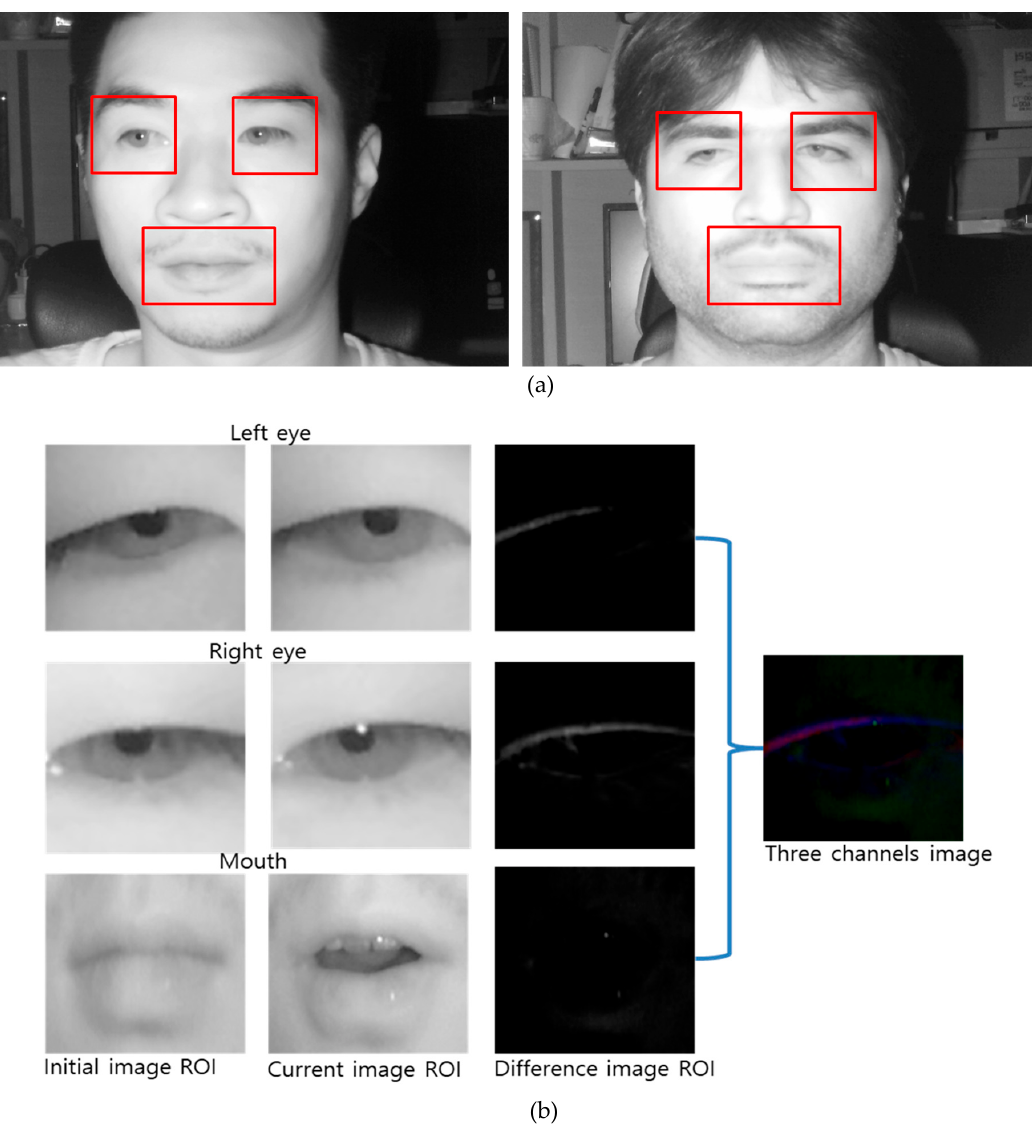
Figure 7. NIR image for showing facial emotions: ( a ) selected ROIs for emotions; ( b ) for facial emotions difference image generation .